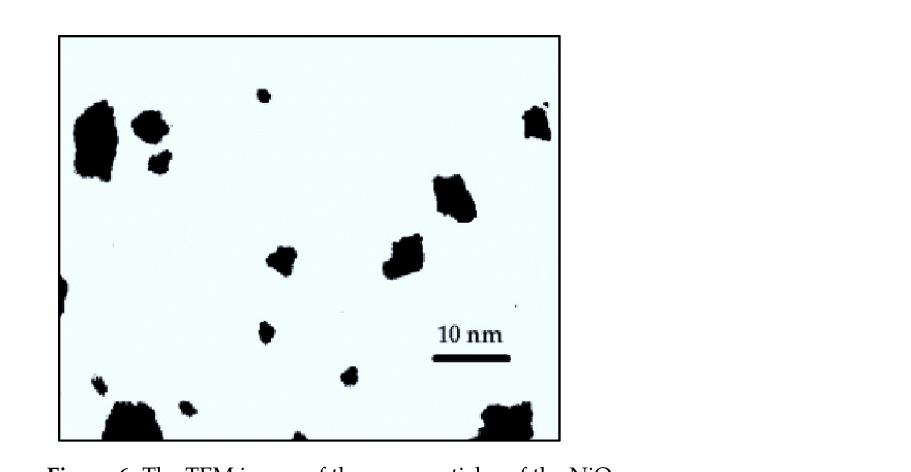
Figure 5. XRD patterns of nano-NiO/ γ -A1 2 O 3 .